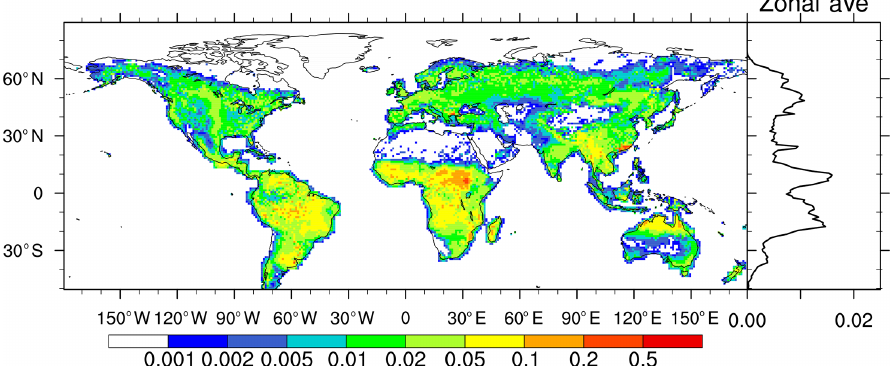
Figure 3. Inter-model standard deviation of 2003–2008 averaged fire BC emissions (gBCm − 2 yr − 1 ) in FireMIP models and the zonal average.